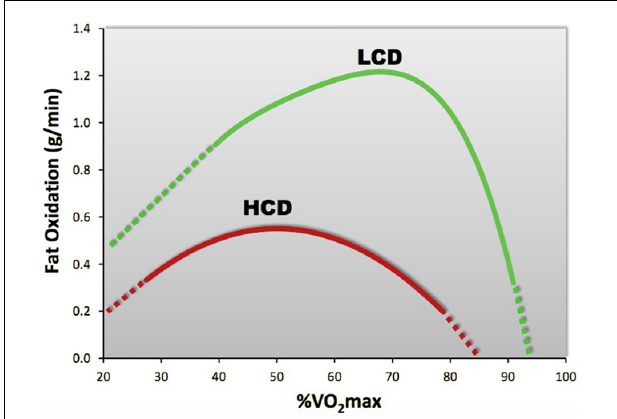
FIGURE 3 | Compared to a high-carbohydrate diet (HCD), a high fat, low-carbohydrate diet (LCD) significantly increases fat oxidation rates. [Adapted from Volek et al.